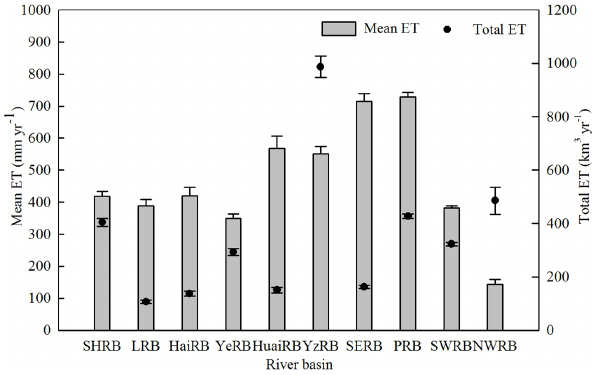
Fig. 6. The annual and total ET averaged over the period from 2000 to 2010 in 10 river basins: SHRB – Songhua River basin; LRB